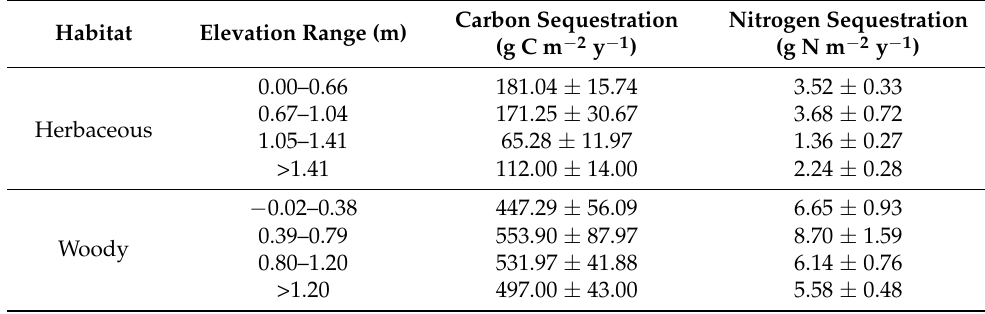
Table 2. Nutrient (carbon and nitrogen) sequestration rates based on habitat type and elevation